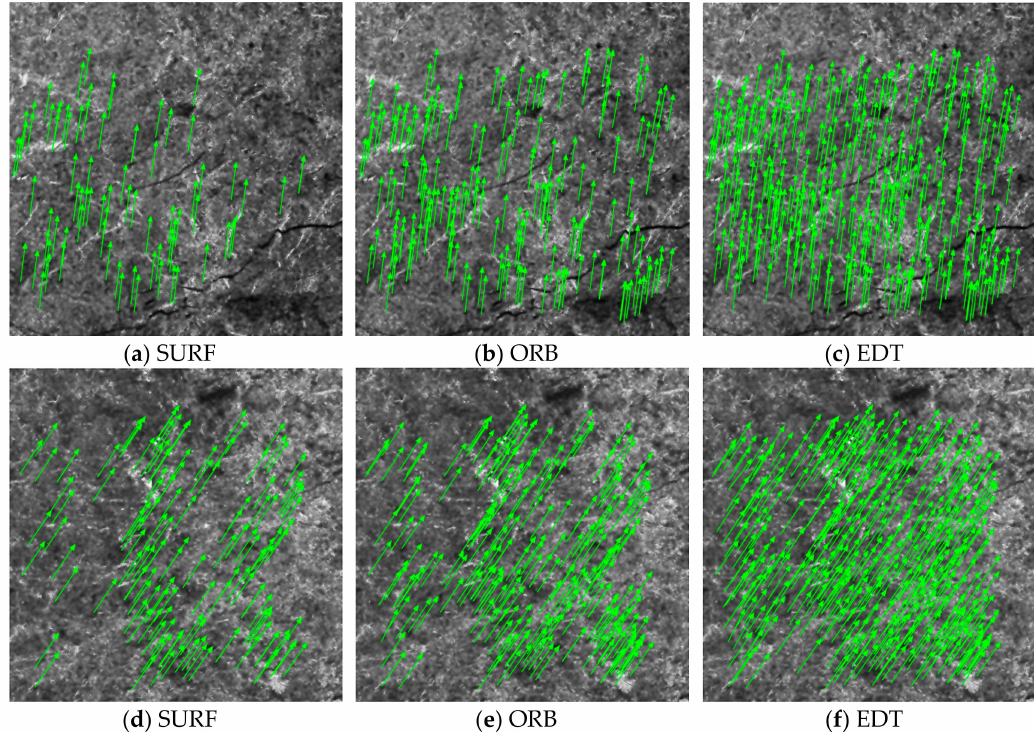
Figure 12. Visualization of sea ice drift vectors with the SURF, ORB, and EDT methods. Results of ( a ) SURF, ( b ) ORB and ( c ) EDT methods for case 1. Results of ( d ) SURF, ( e ) ORB and ( f ) EDT methods for case 2.